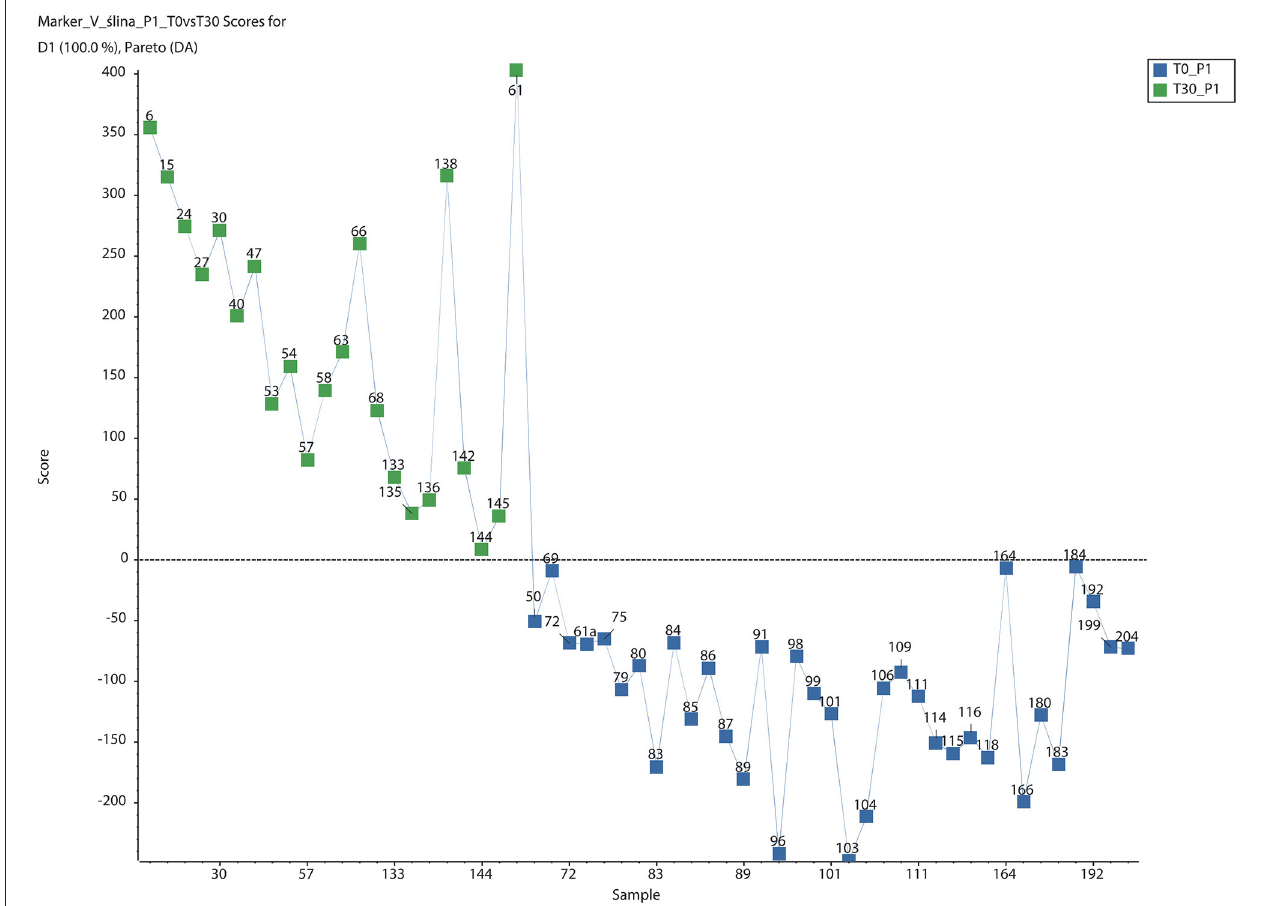
FIGURE 1 | PCA-DA Score plots for saliva of dogs after 30-day-long period of placebo administration. Green boxes and blue boxes represent metabolome of sample from dogs in day 0 and day 30 after placebo administration, respectively (PCA-DA, Scaling PARETO, SCIEX MarkerView TM ).